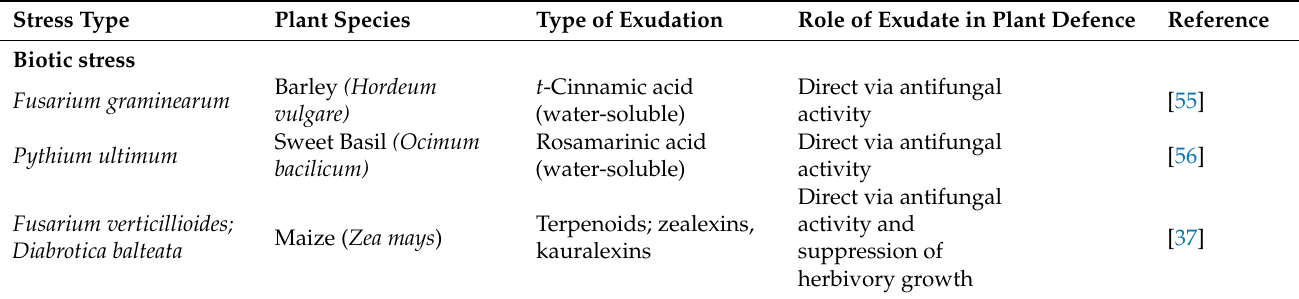
Table 1. Representative studies where plants under various stresses can produce specific root metabolites that can directly and indirectly (via recruitment/modulation of beneficial root associated microbiome) affect plant